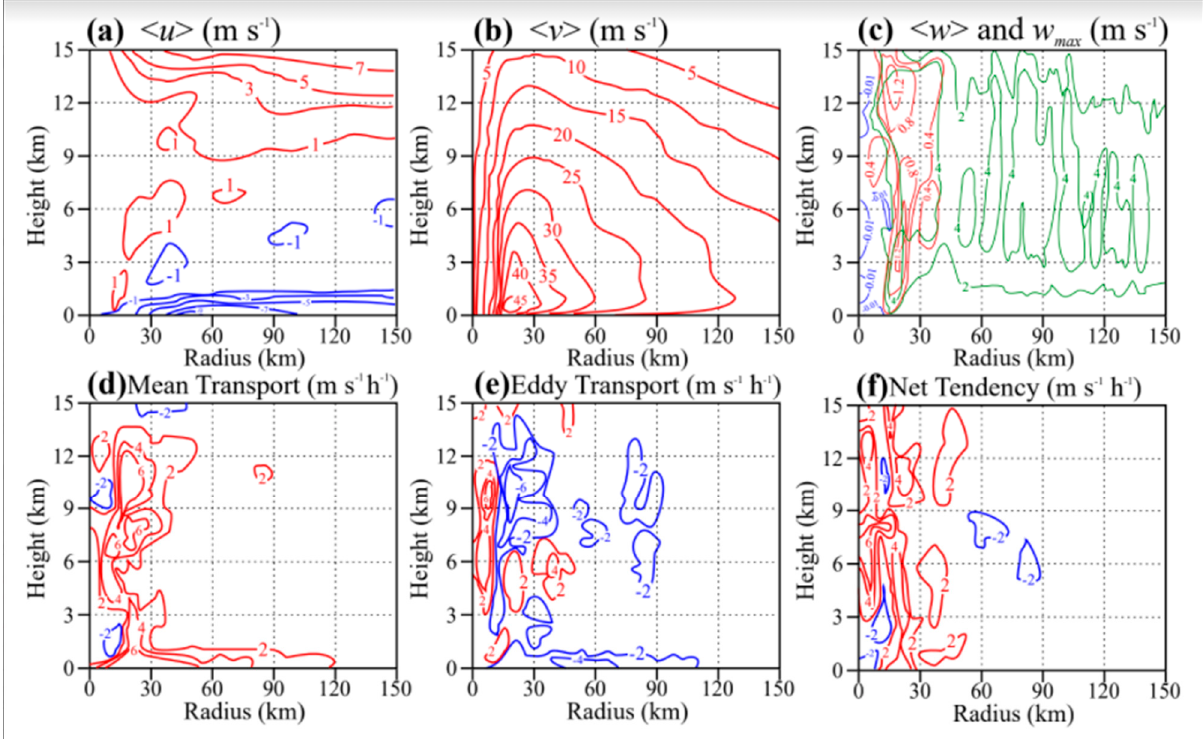
Figure 15. As in Figure 12, except that it shows a 56 h HWRF forecast of Hurricane Michael. The x -axis shows the radius from 0–150 km.